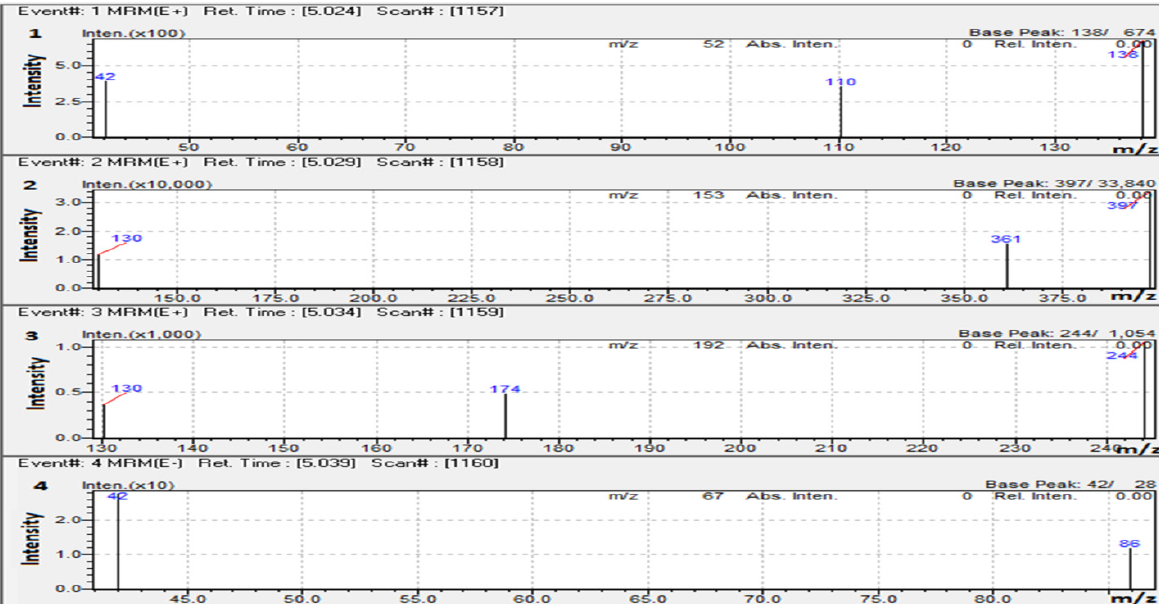
Figure 3. MRM chromatograms of ( 1 ). (50.00 ng/mL) Caffeine, ( 2 ). (100.00 ng/mL) Doxorubicin, ( 3 ). (20.00 ng/mL) Capecitabine, and ( 4 ). (200.00 ng/mL) 5-Fluorouracil.